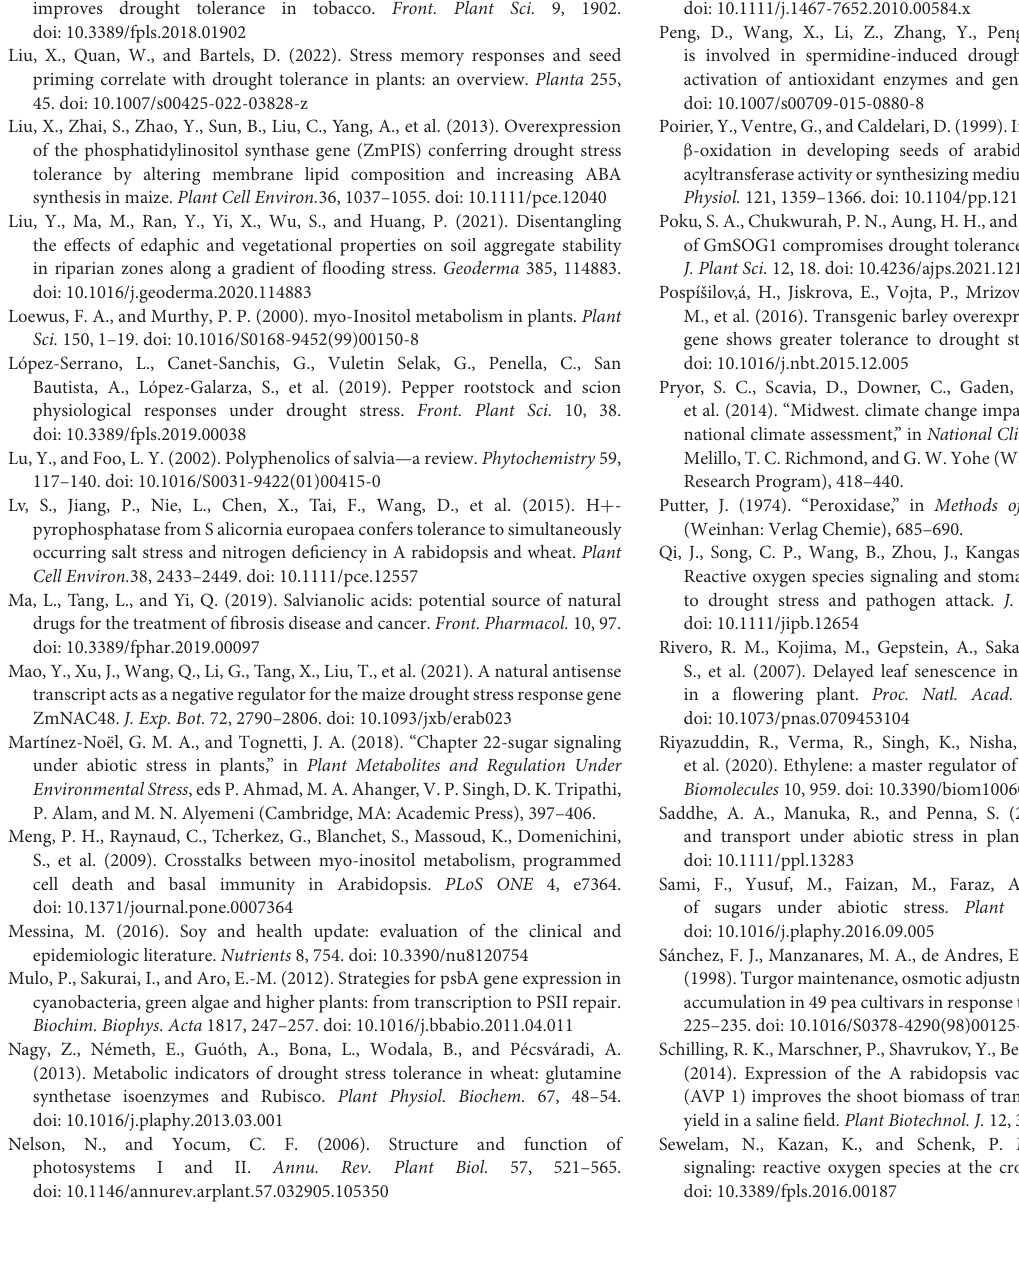
Frontiers in Plant Science |